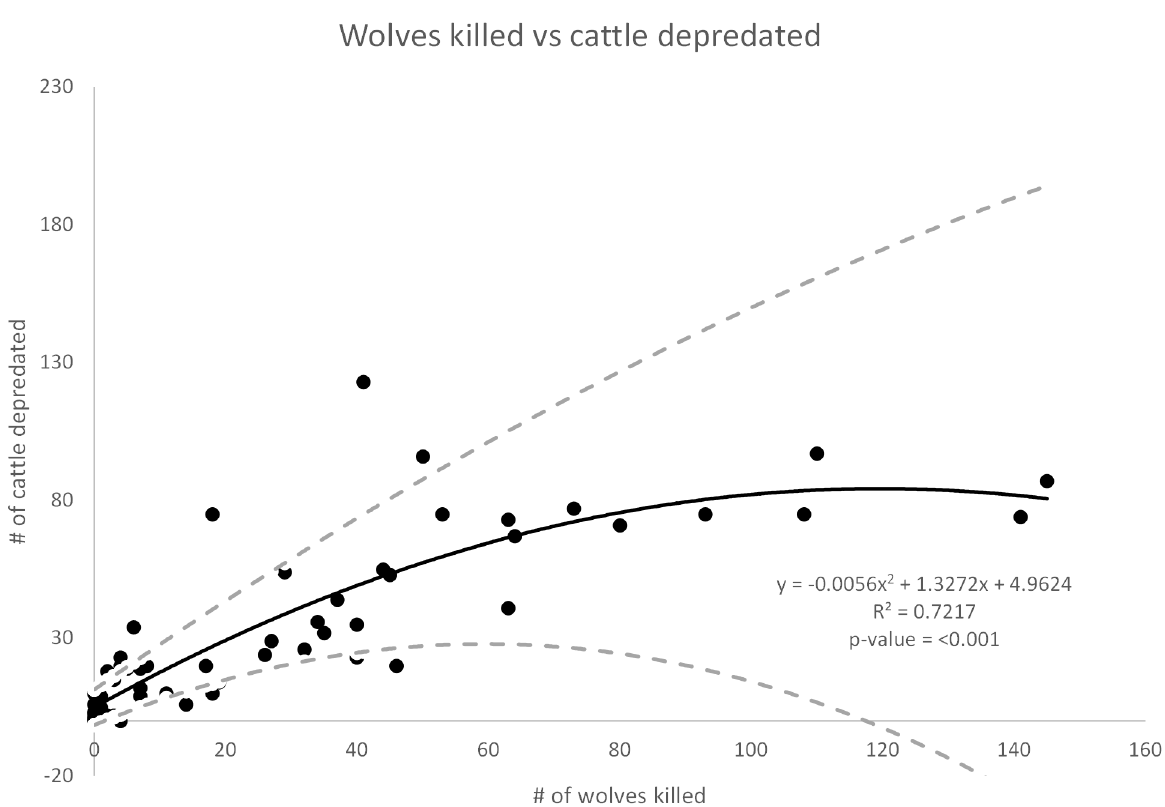
Figure 1. Wolves killed vs cattle depredated. Number of wolves killed through control methods the previous year versus the number of cattle depredated the following year. The dashed lines show the upper and lower limits of the 95% confidence interval for the best fit